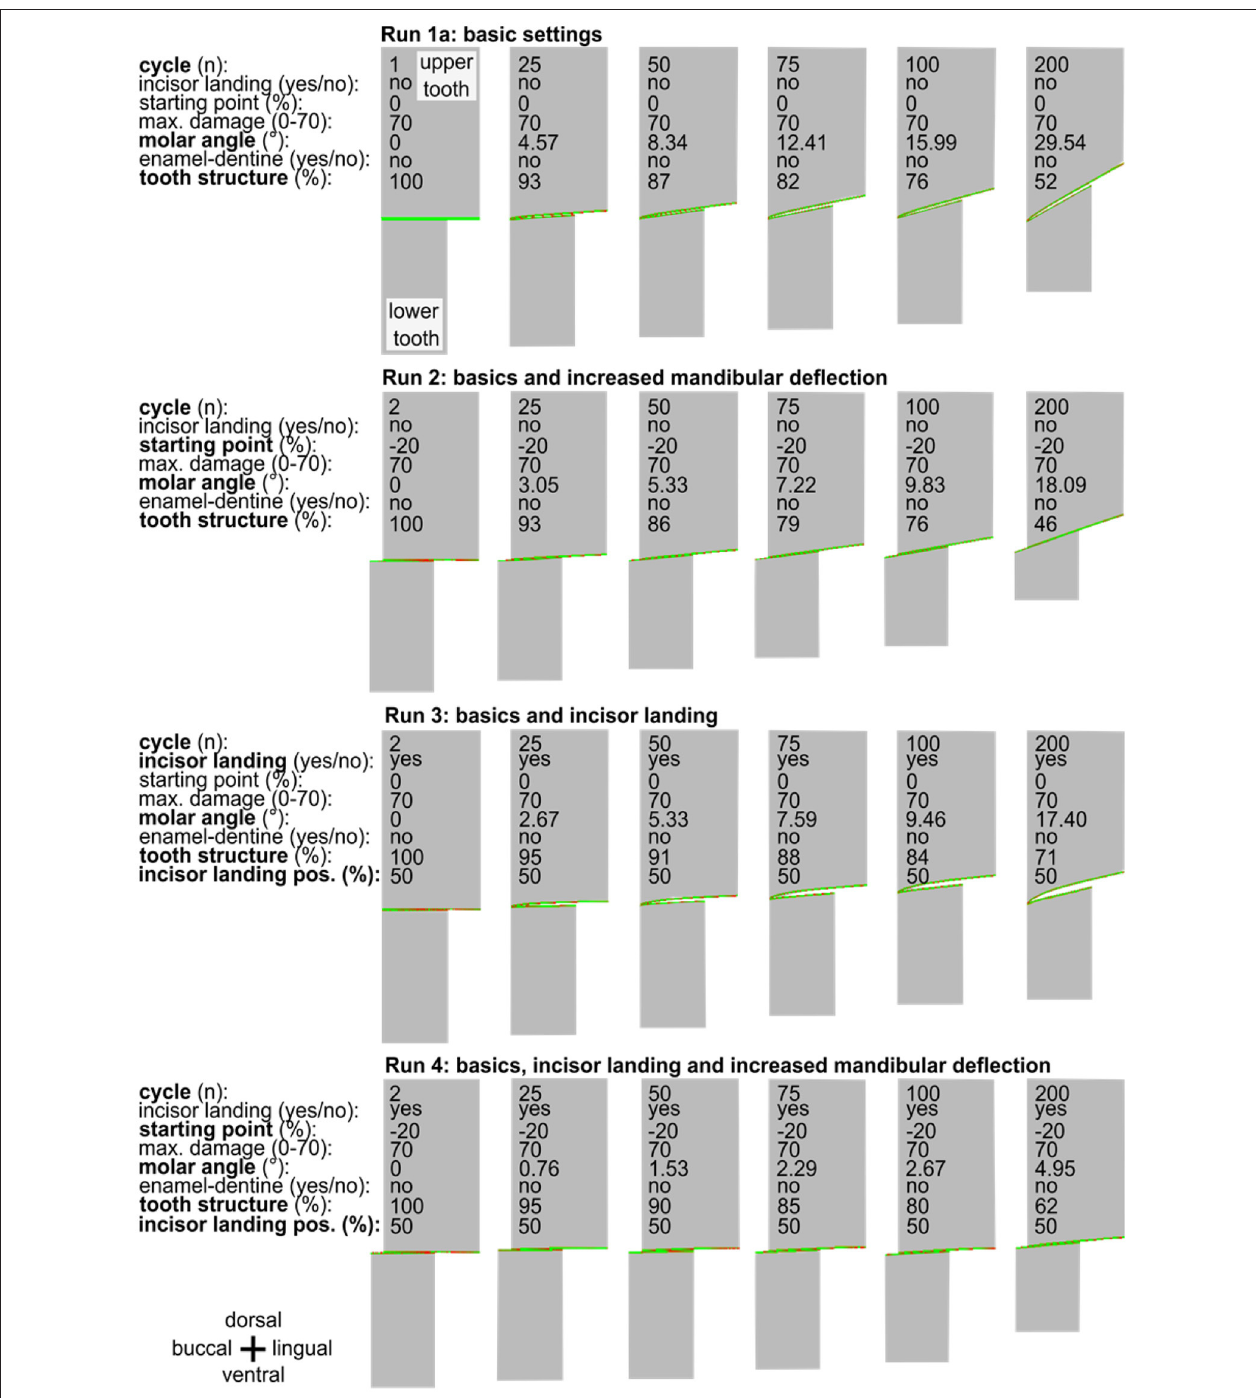
FIGURE 3 | A series of simulation runs (1a to 4) displayed for two occluding cheek teeth varying the simulation settings (basics, incisor landing, and mandibular deflection). In each run from left to right, six selected points in time—each at the beginning of the power stroke—are presented for chewing cycle number 2, 25, 50, 75, 100, and 200. The inclination of the cheek teeth from buccal to lingual (left to right) is constantly increasing during the simulation, reaching various molar inclinations in cycle 200. Note the observation of a marked edge on the buccal side of the upper tooth in run 3.